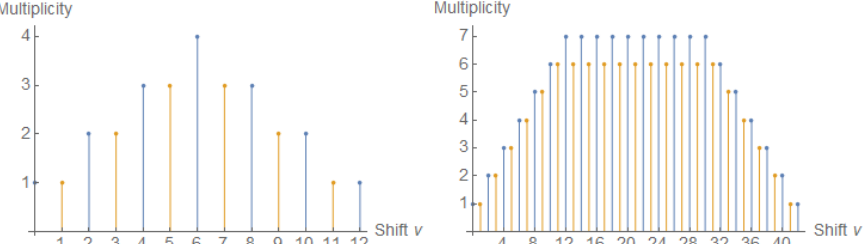
Figure 3 . Even and odd spins are in blue and orange respectively. On the left is the multiplicity for (cid:28) = 20 and on the right is the multiplicity for (cid:28) = 50 of the same R-symmetry representation. Given eq. (4.30), the maximal multiplicity for [2, 12, 2] is 7 and 6 for even and odd spin